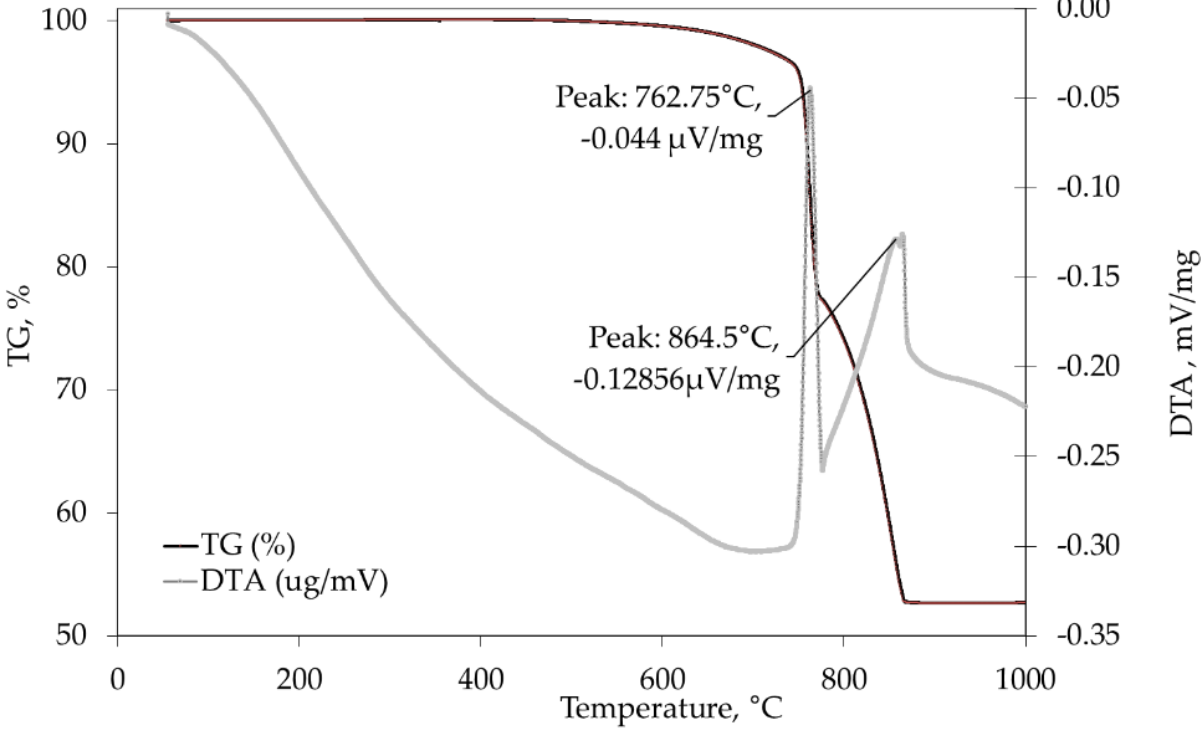
Figure 2. TG/DTA graph of dolomite aggregates.